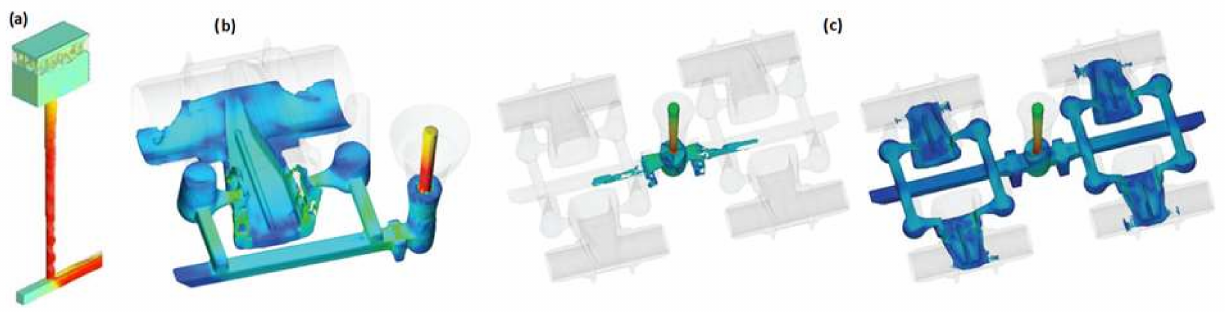
Figure 2. Lack of pressurization in the bottom part of sprue ( a ) [17]; unpressurized sprue ( b ) [18] and ( c )